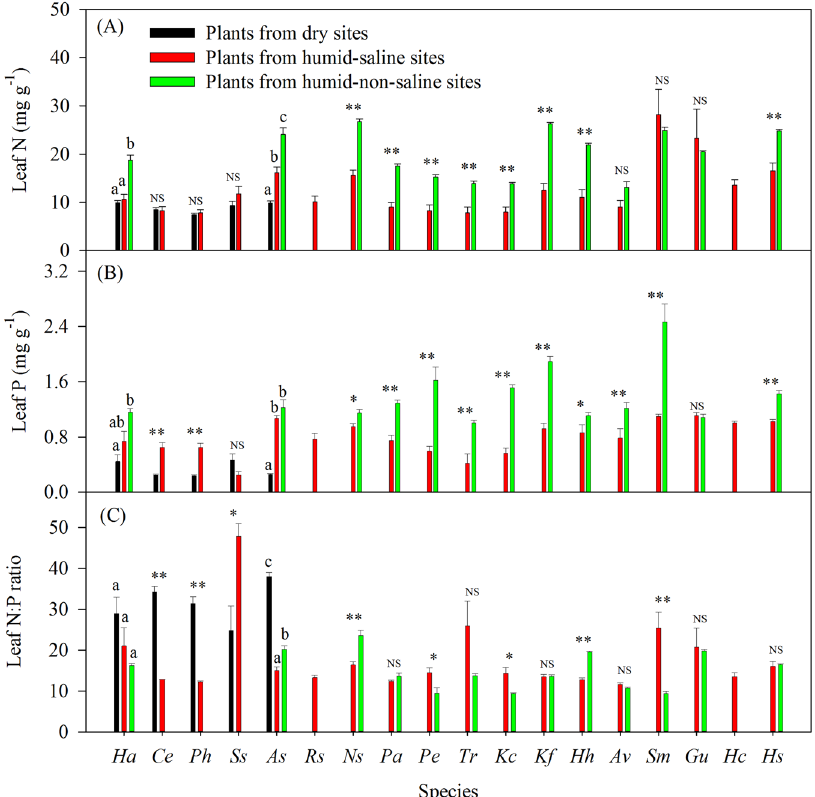
Figure 3. Comparisons of species stoichiometry between dry and humid-saline sites and humid-non-saline sites, respectively. Significant differences are reported from ANOVA as NS, P ≥ 0.05; * P < 0.05; ** P < 0.01. Following ANOVA, multiple comparisons were conducted using Protected Least Significant Difference (LSD); any two samples with a common letter (a, b or c) are not significantly different (P > 0.05) The abbreviations of species refer to the note in Table